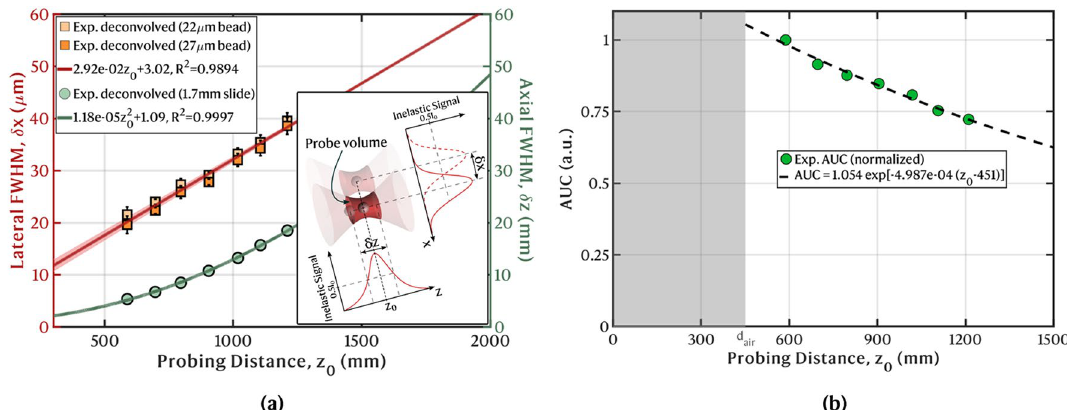
Figure 3. ( a ) Underwater axial ( δ z ) and lateral ( δ x ) Richardson-Lucy deconvolved resolutions as a function of the probing distance, z 0 , with quadratic and linear regressions, respectively. For δ x , the data points from the deconvolution with 22 μm and 27 μm microspheres are plotted to portray the limit cases; the mean is used to determine the fit. Inset: illustration of the probe volume integrated to obtain the intensity of a single pixel. ( b ) Integral of the deconvolved weighting functions (AUC) as a function of the probing distance z 0 , normalized by the value measured at the closest distance. The datapoints are fitted with an exponential loss function that models the absorption in the underwater optical path ( z 0 − d air ) according to Beer’s law. The shaded region represents propagation in